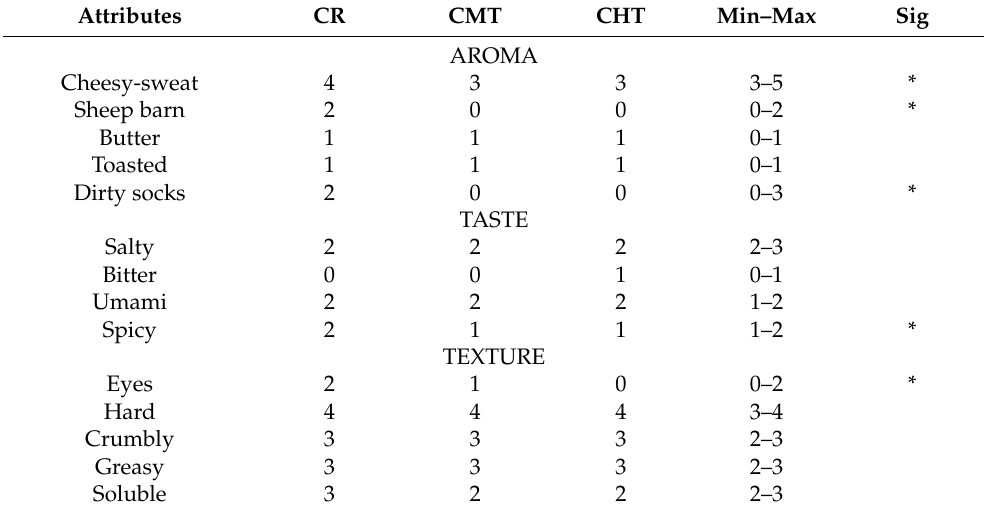
Table 3. Sensory attributes (modal values) for Canestrato cheese made from raw and thermized milk at 300 days of ripening. CR = raw milk cheese; CMT = mild-thermized cheese; CHT = high-thermized cheese. Sig = statistical significance (* = different at p <